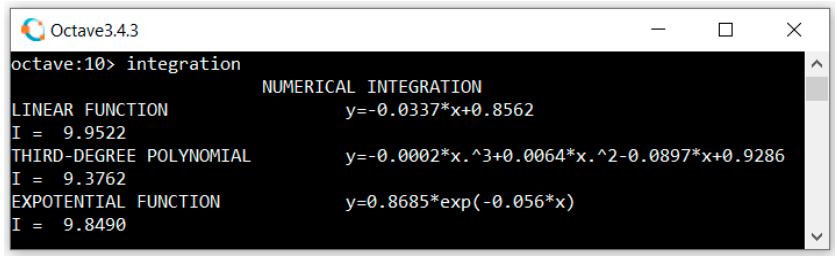
Figure 6. Result of applying the “quad” feature.